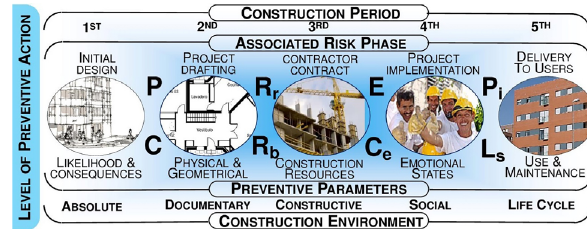
Figure 1. Environment outlines and its associated